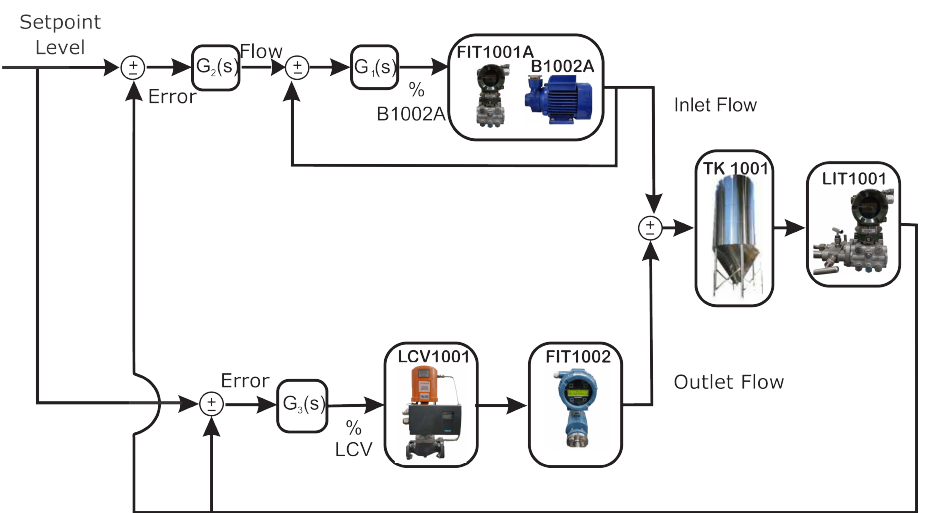
Figure 8. Control grid of the didactic